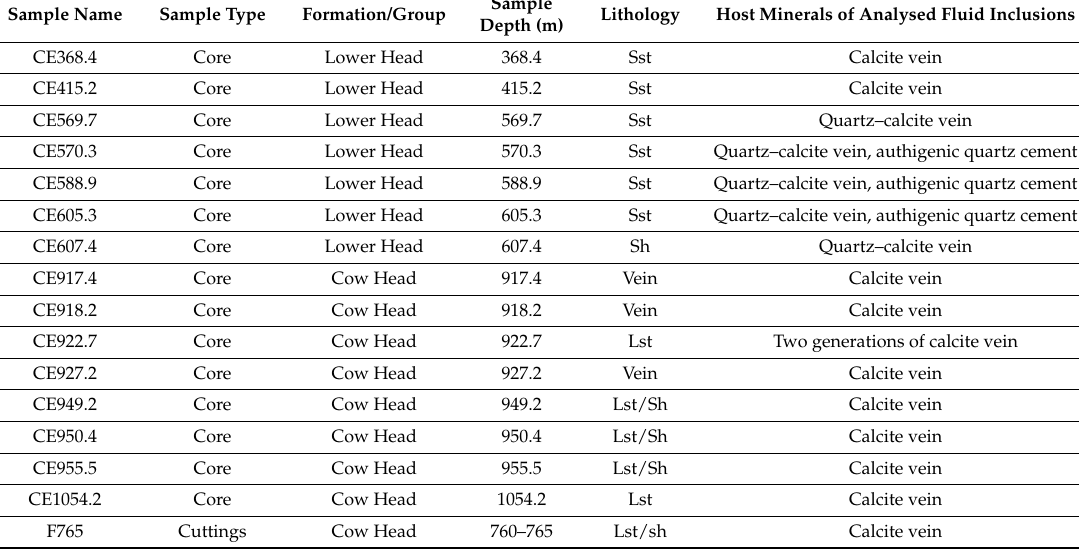
Table 1. Sample locations and brief lithological descriptions from Parsons Pond #1 well (prefix